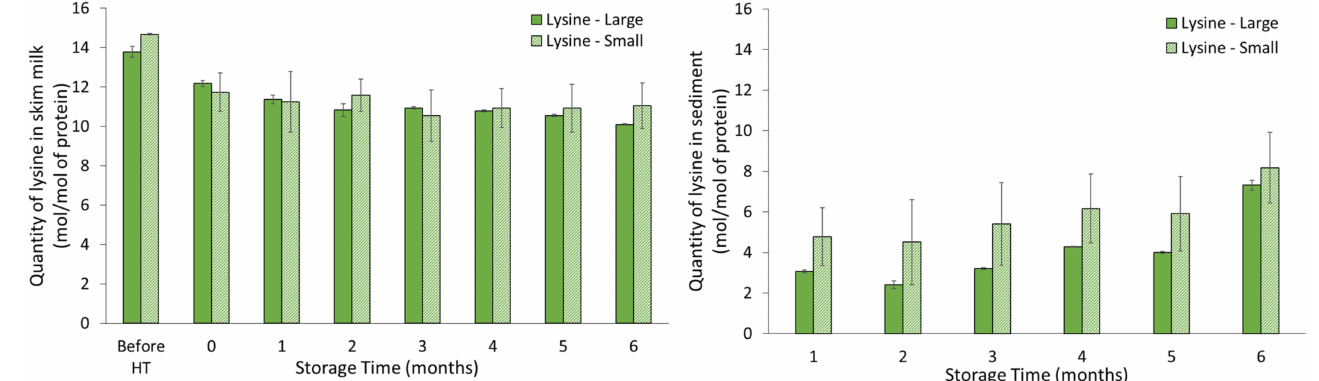
Figure 3. Development in molar levels of lysine quantification in UHT milk for ( left ) skim milk and ( right ) sediment during storage at 40 ◦ C. ‘Large’ and ‘Small’ indicate UHT milk prepared from raw milk representing large or small casein micelles,